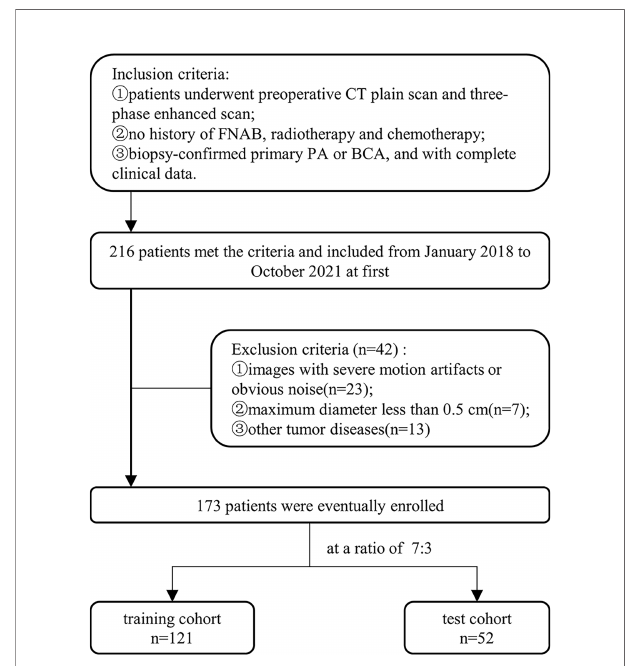
FIGURE 1 | Work fl ow for patient